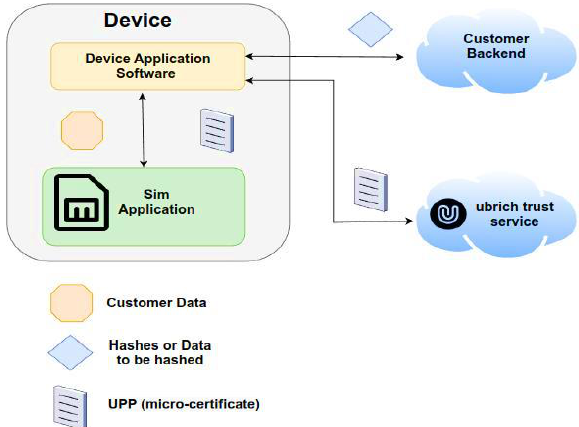
Figure 25. UBIRCH application structure diagram (Ubirch).